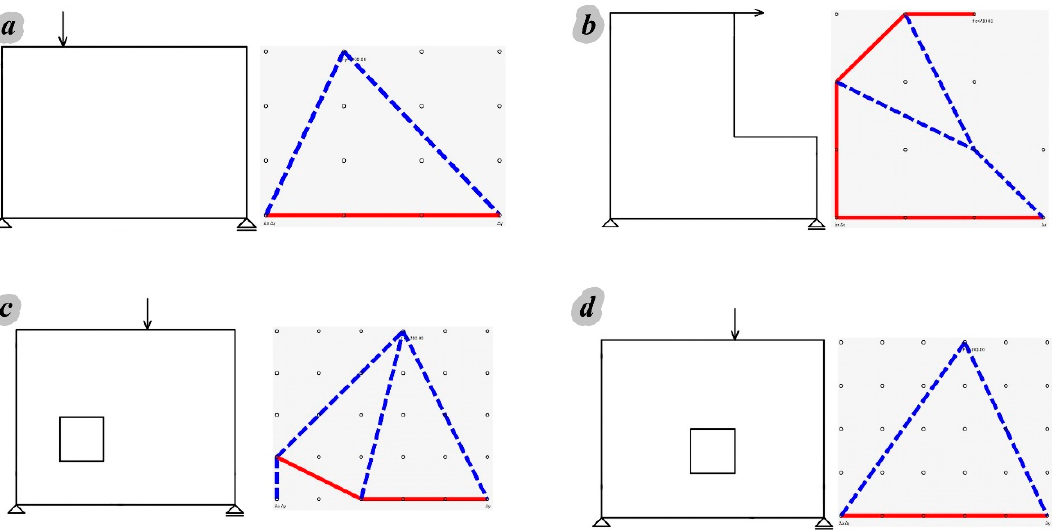
Figure 2. Strut-and-Tie models obtained with the software “ST method” for: ( a ) regular deep beam; ( b ) irregular deep beam; ( c ) regular deep beam with an opening on the left ( d ) regular deep beam with an opening in the middle.